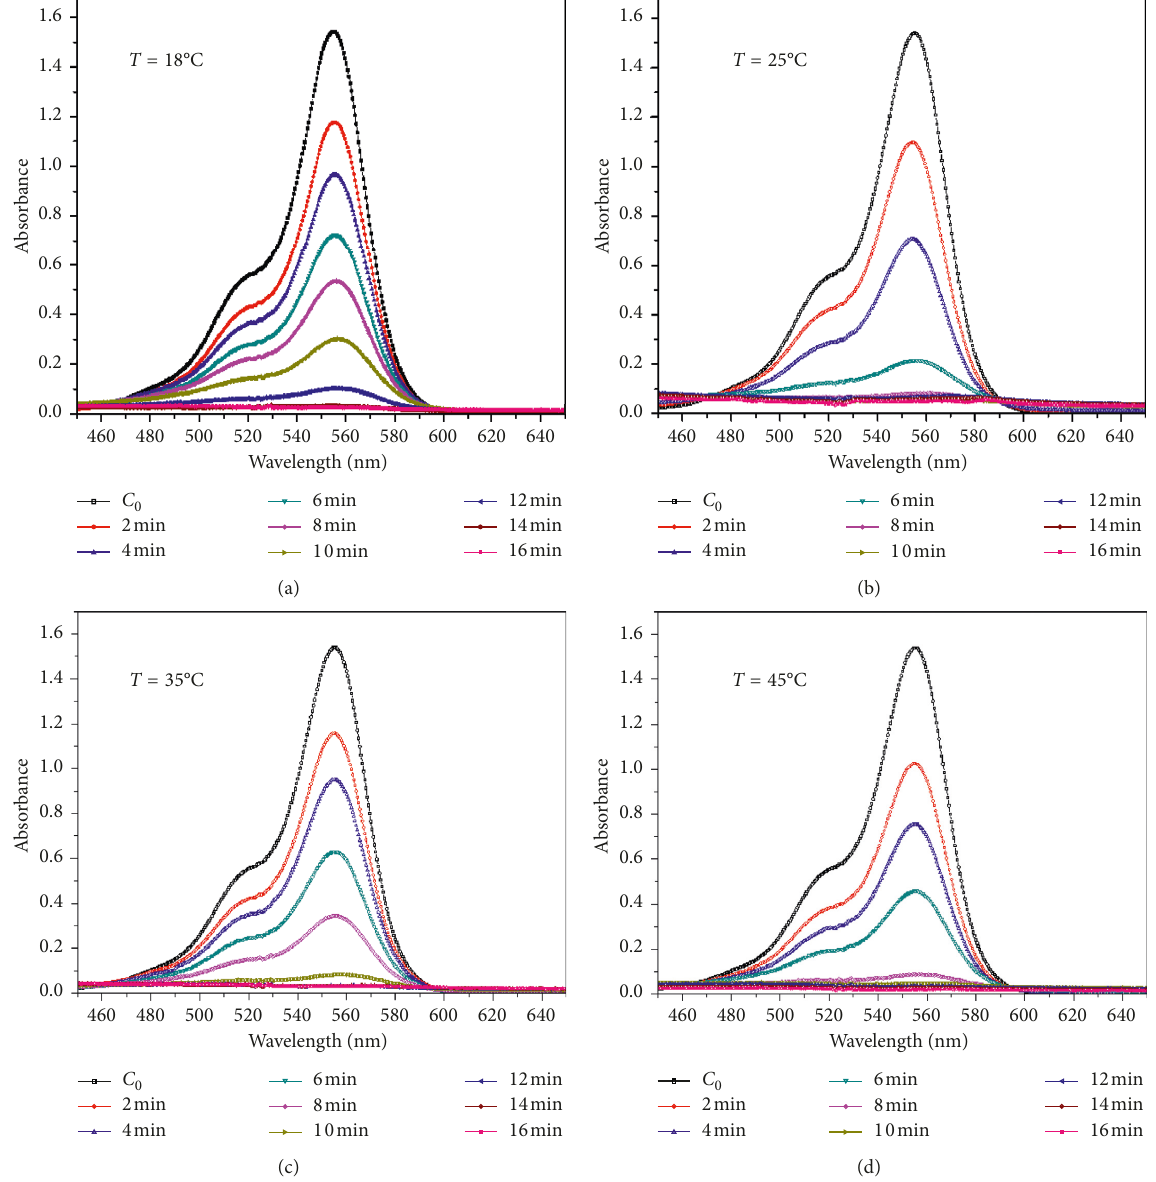
Figure 7: Spectra of samples taken at various times of electrolysis in different temperatures. Conditions: current density, 3.9 mA · cm − 2 ; [NaCl], 0.07mol · L − 1 ; [Rh-B], 80 mg · L − 1 ; flow rate, 30L · h − 1